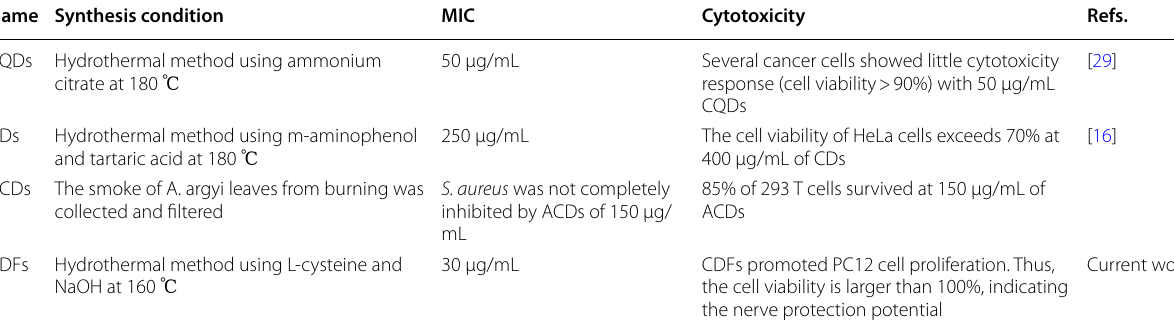
Table 2 Synthesis of CDs and the eradication of S. aureus